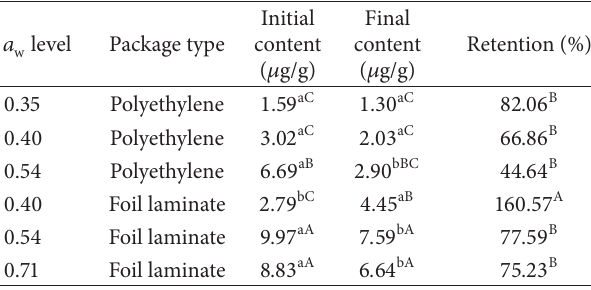
Table 6: 𝛼 -Tocopherol content of dehydrated taro slices stored for and in different packaging materials 1 . 34 weeks at different 𝑎 w